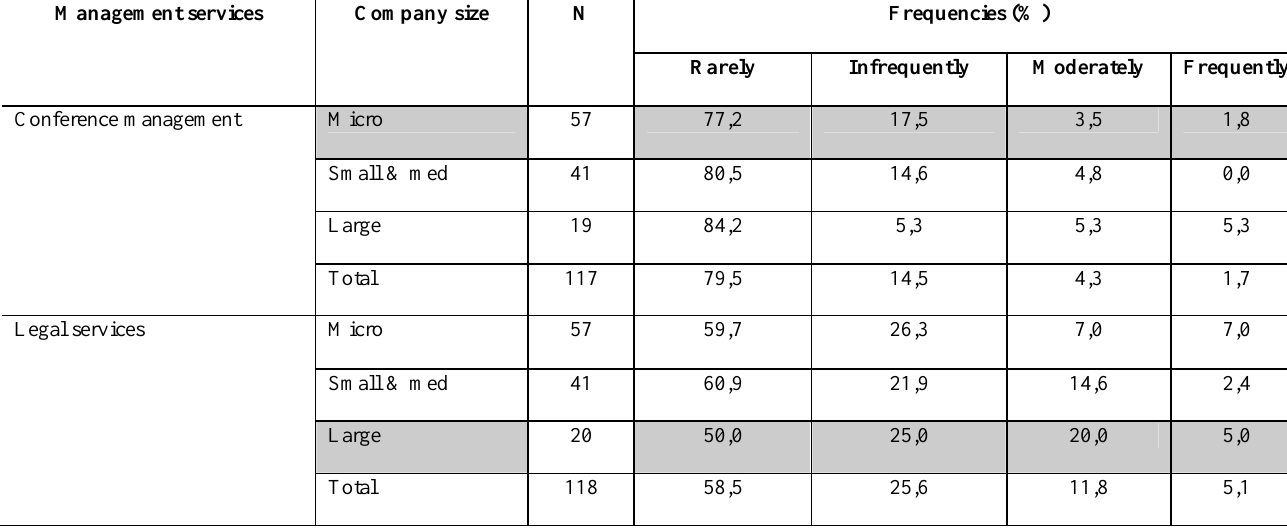
Table 4: Comparison between company size and responses to management